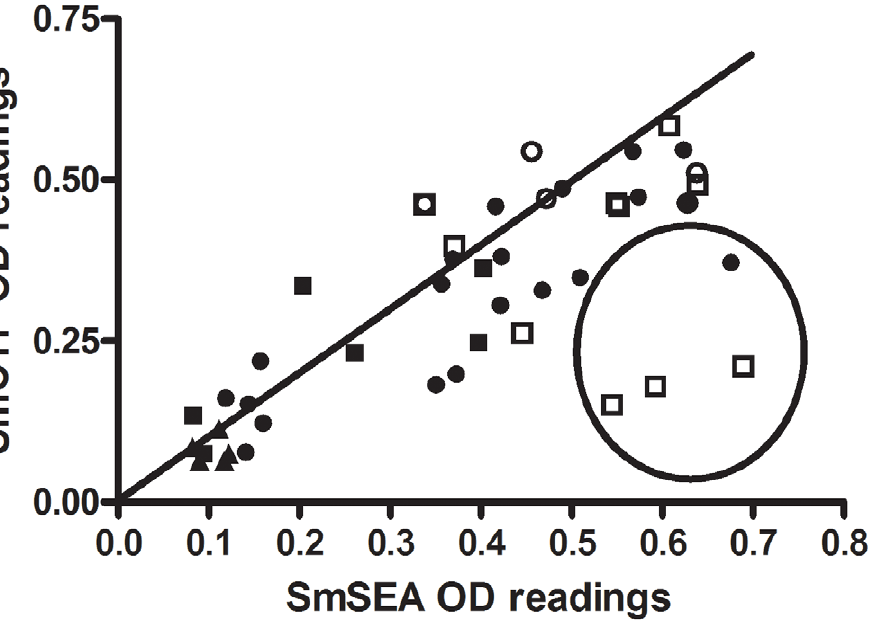
Figure 9. AMC: correlation between S.mansoni cercarial transformation fluid (SmCTF) and soluble egg antigen (SmSEA) in ELISA. Results for sera from a total of 46 subjects: 21 from patients with parasitologically-proven schistosome infections, 20 sera that were positive in routine N serology and 5 negative controls. % =sera from patients known to be S. mansoni -infected; # =sera from patients known to be S. haematobium - =sera from patients that tested positive for schistosomiasis in routine serology, but were infected; & =sera from patients with Katayama fever; egg-negative; m =control negative sera from patients that tested negative in routine serology.